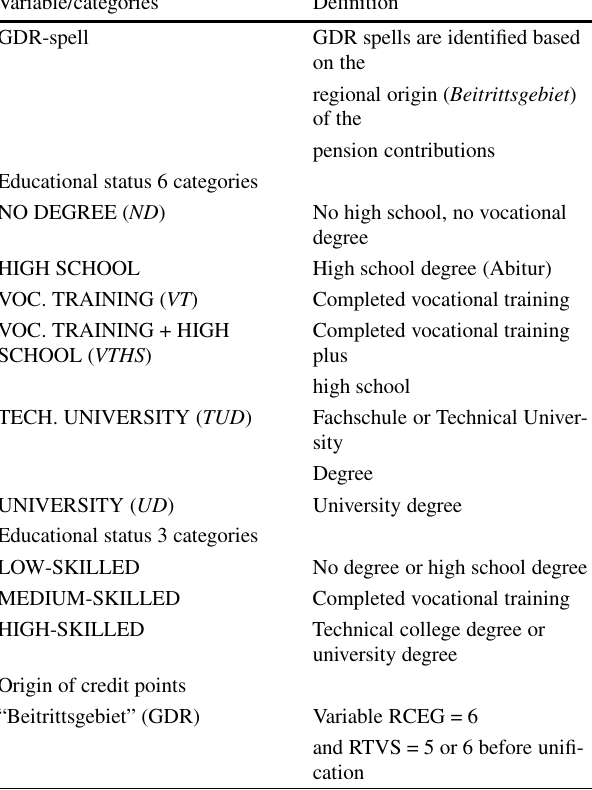
Table 15 Definition of individuals characteristics